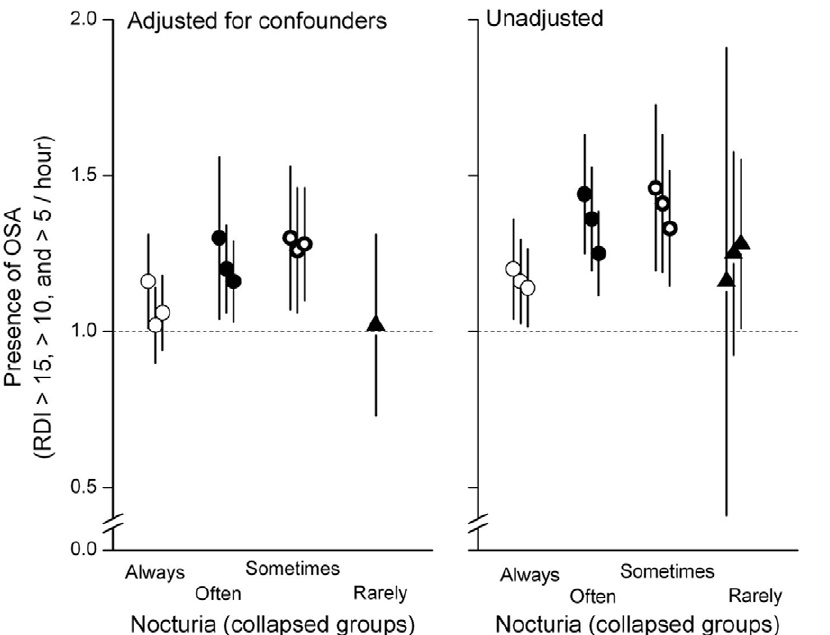
Figure 2. Association between nocturia and presence of sleep-disordered breathing based upon different apnea-hypopnea index (AHI) thresholds are shown as odds ratio ( symbol ) and 95% confidence intervals ( y-errorbars ). Odds ratios and respective confidence intervals that were adjusted for confounders ( left panel ) and unadjusted for confounders ( right panel ) are shown. The x-axis of each panel represents nocturia expressed as a dichotomous categorical variable (nocturia present or absent) by progressively increasing the threshold level of collapse from ‘rarely’ to ‘always’ to yield four different dichotomous variables for nocturia. The cluster of three symbols with corresponding error bars for each definition of nocturia correspond to variable AHI thresholds for nocturia from left-to-right ( . 15, . 10 and . 5 per hour, respectively). For nocturia defined as greater than rarely ( closed triangle ) only one adjusted odds ratio is shown ( left panel ) because multivariate regression was performed only if univariate regression was significant at P , 0.05 (see